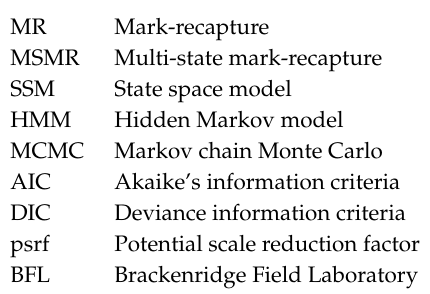
Figure S1: Density-dependent survival results, Figure S2: Untransformed parameter values, Table S1: Model selection results, Supplement S1: R code and demographic data, Supplement S2: Climatic